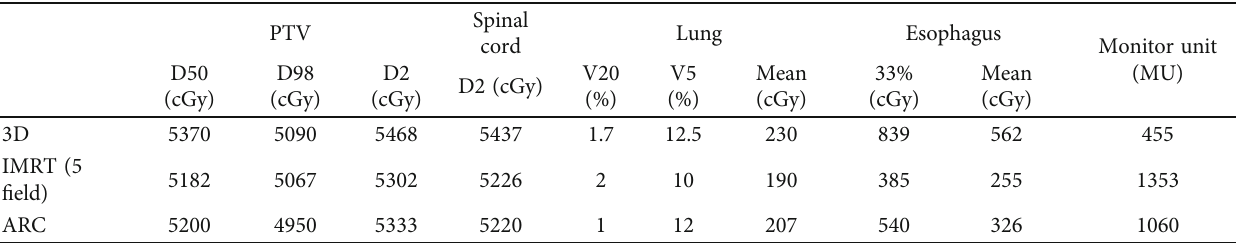
Table 1: Comparison of treatment plans.